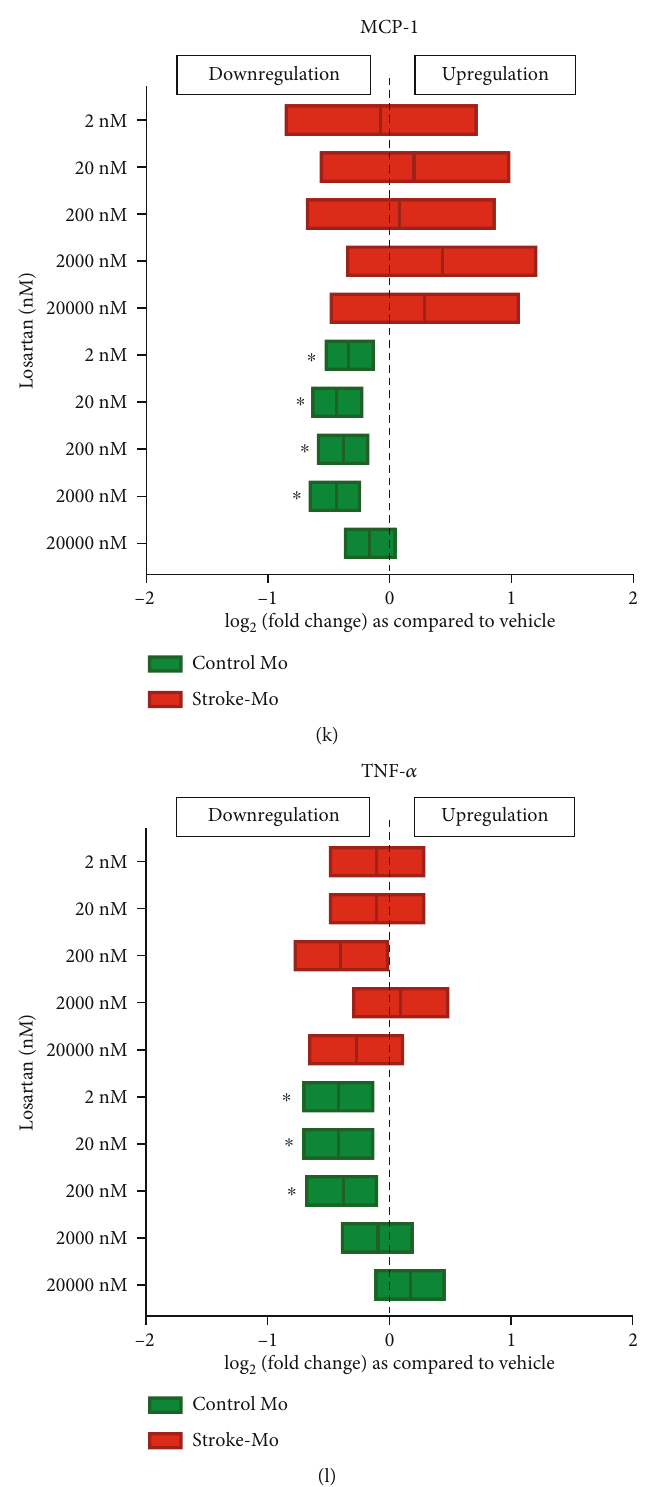
Figure 1: Antihypertensive medications alter the secretome of monocytes from healthy controls and stroke patients after 24 hours of exposure. Atenolol (a – d) increased IL-1RA and TNF- α secretions from stroke patient-derived monocytes but reduced the IL-1RA and MCP-1 secretions from health control monocytes. Captopril (e – h) increased IL-1RA secretions from stroke patient-derived monocytes but increased IL-8 secretions from both healthy control and stroke monocytes. Losartan (i – l) did not alter cytokine secretions from stroke patient-derived monocytes but reduced MCP-1 secretions from healthy control monocytes. Signi fi cance is shown by ∗ p < 0 : 05 . All fold changes are as compared to vehicle